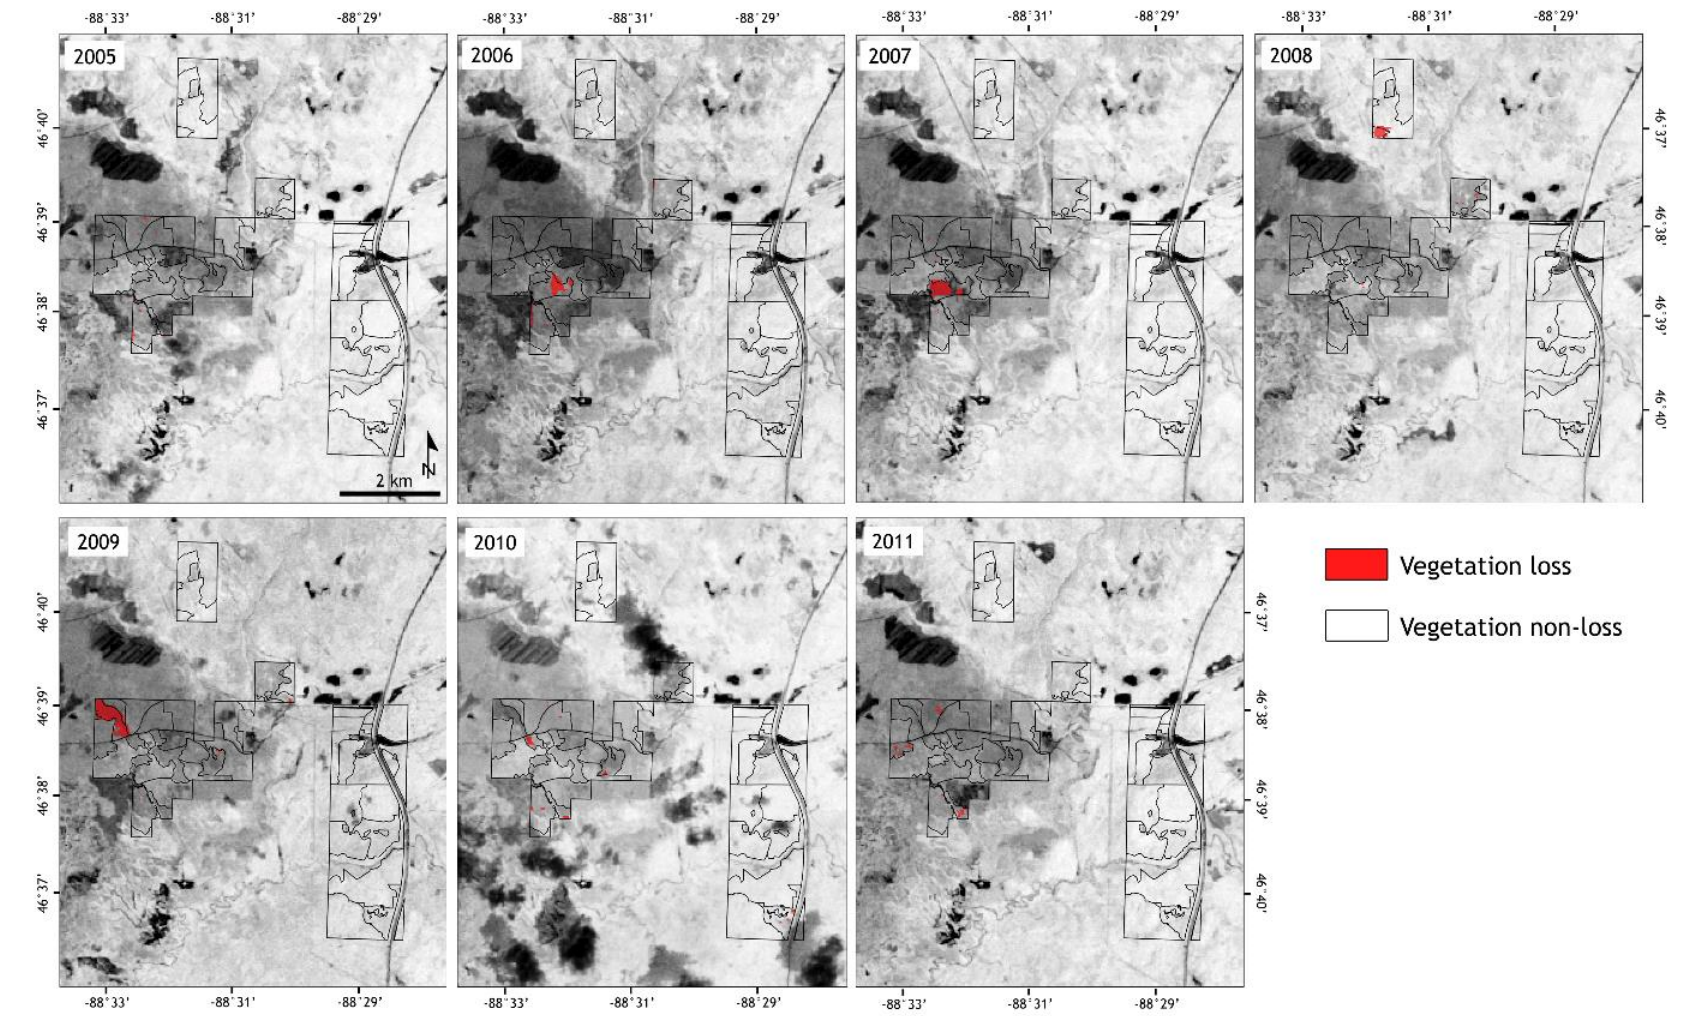
Figure 4. Global Forest Watch classification overlaid onto the 2005–2011 NDVI